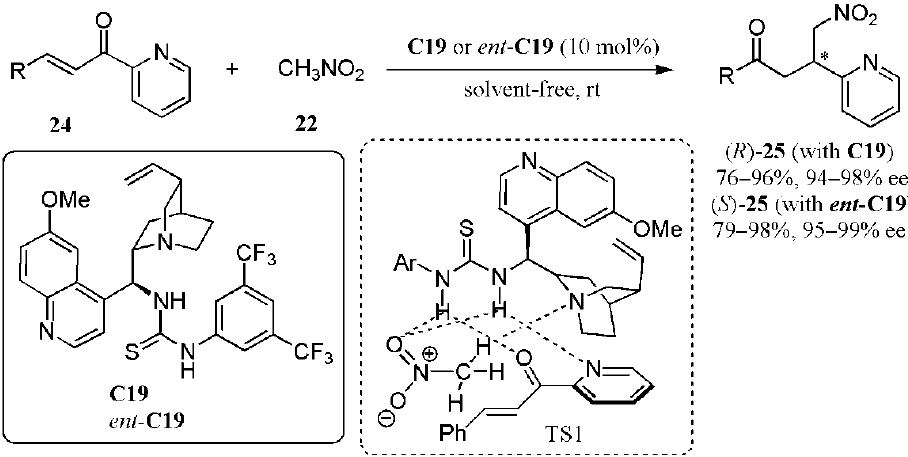
Figure 20. Solvent-free enantioselective conjugate addition of nitromethane to chalcone-containing pyridine